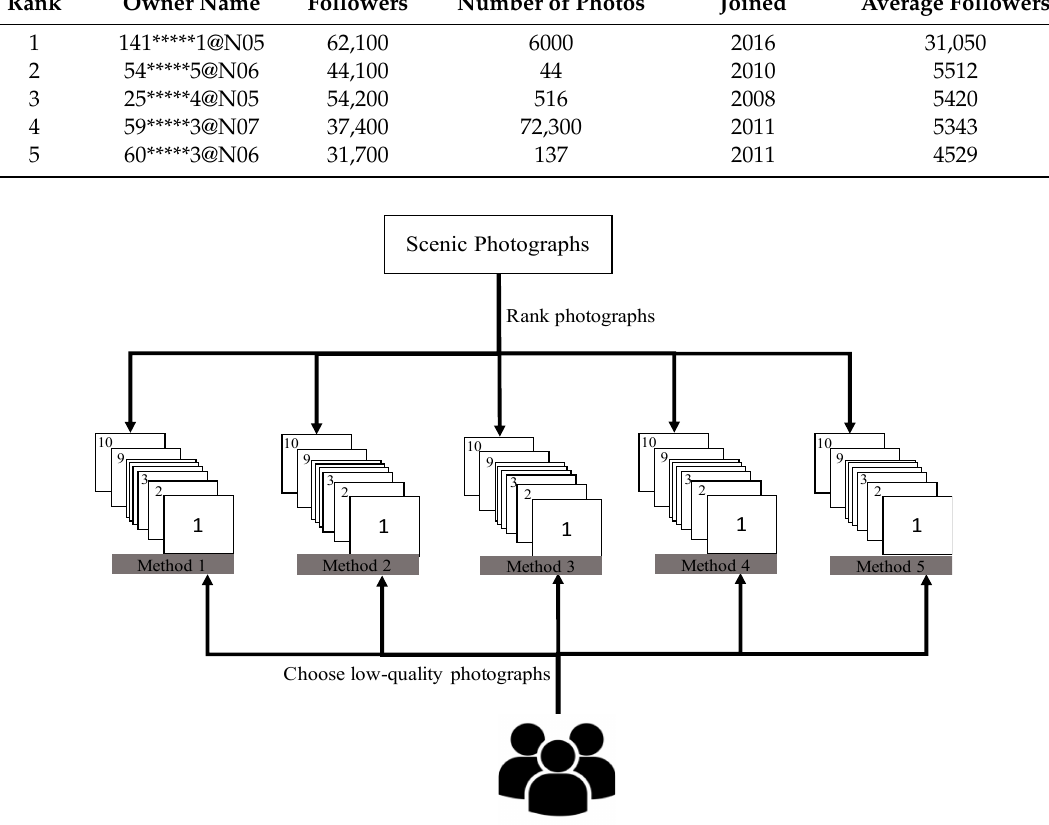
Figure 4. Schema of questionnaire survey.